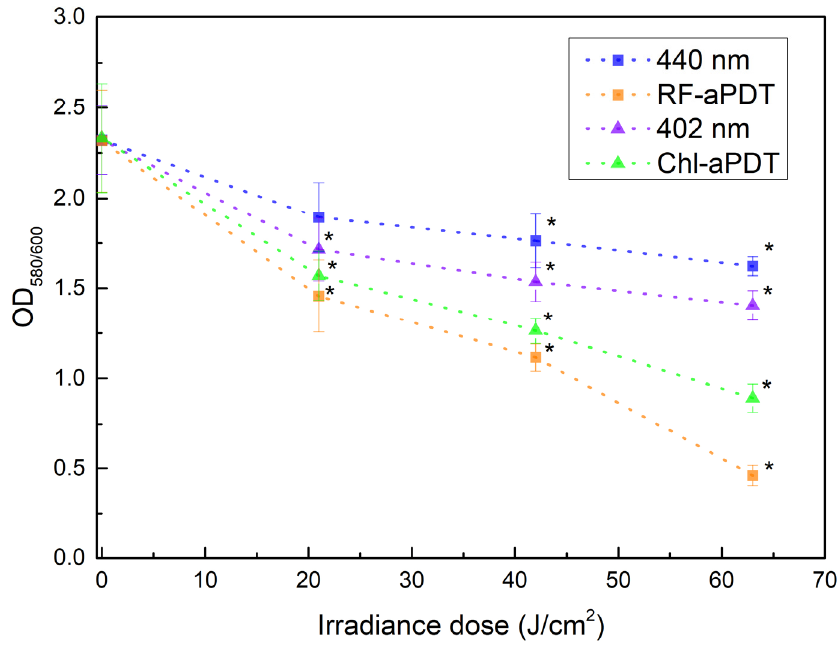
Figure 2. Detection of reactive oxygen species (ROS) activity in A. baumannii cells based on meas- urements of fluorescence spectra of 2 ′ ,7 ′ -dichlorofluorescein (DCF). 11 µM RF and 15 µM Chl, irra- diance dose of 42 J/cm 2 for both 440 nm and 402 nm LED light was used. The concentration of bac- teria in working solutions was 10 7 CFU/mL. Samples in the legend: Control-1— A. baumannii in 0.01 M PBS buffer without 2 ′ ,7 ′ -dichlorofluorescein-diacetate (DCFH-DA); Control-2— A. baumannii in 0.01 M PBS buffer with DCFH-DA; 440 nm and 402 nm—Control-2 irradiated with 440 nm and 402 nm, respectively; RF-aPDT—Control-2 + RF + 440 nm irradiation; Chl-aPDT—Control-2 + Chl + 402 nm irradiation.